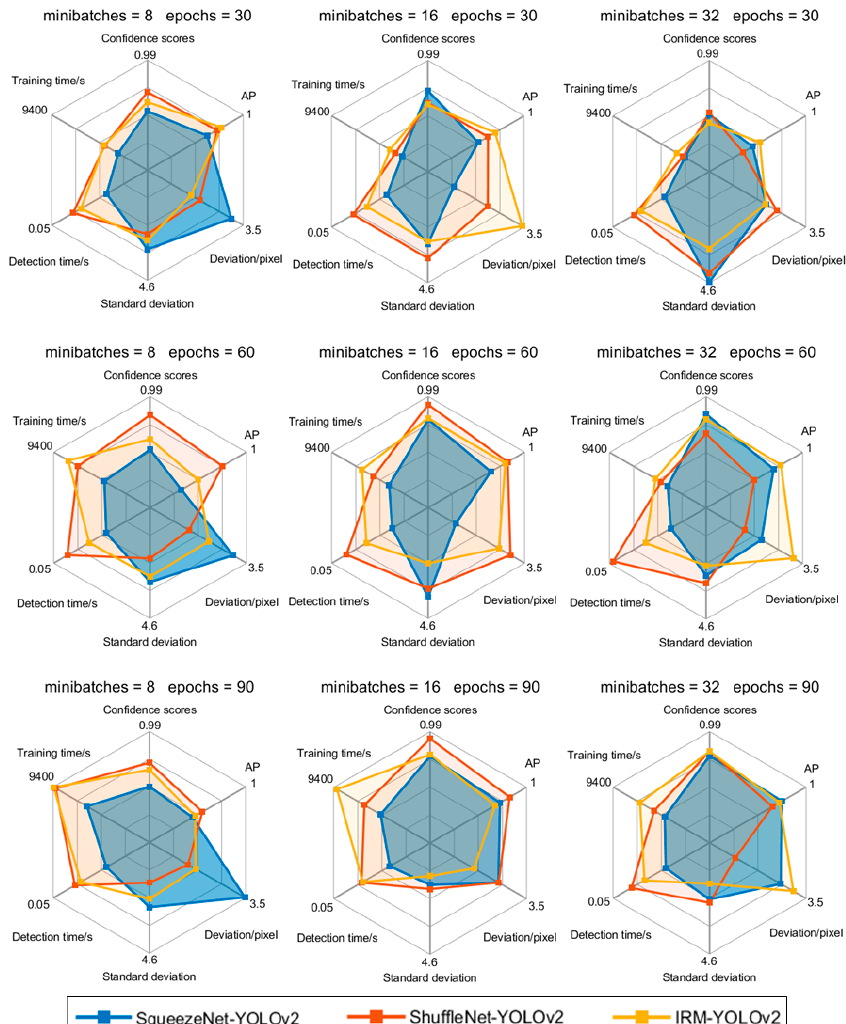
Figure 8. Comparison of lightweight YOLOv2 test results.